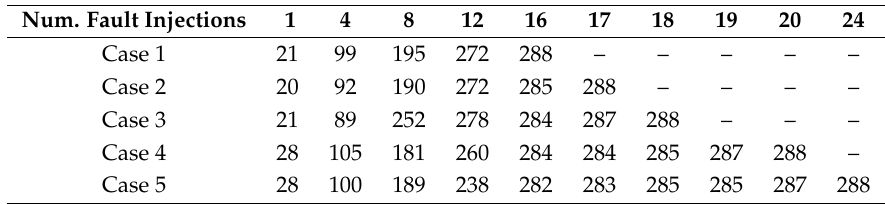
Table 1. Number of injections needed to obtain 288 bits of the internal state.